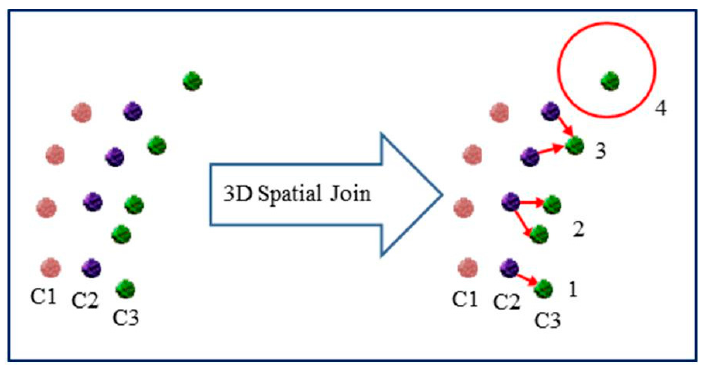
Figure 2. 3D spatial join between points from C2 and C3.